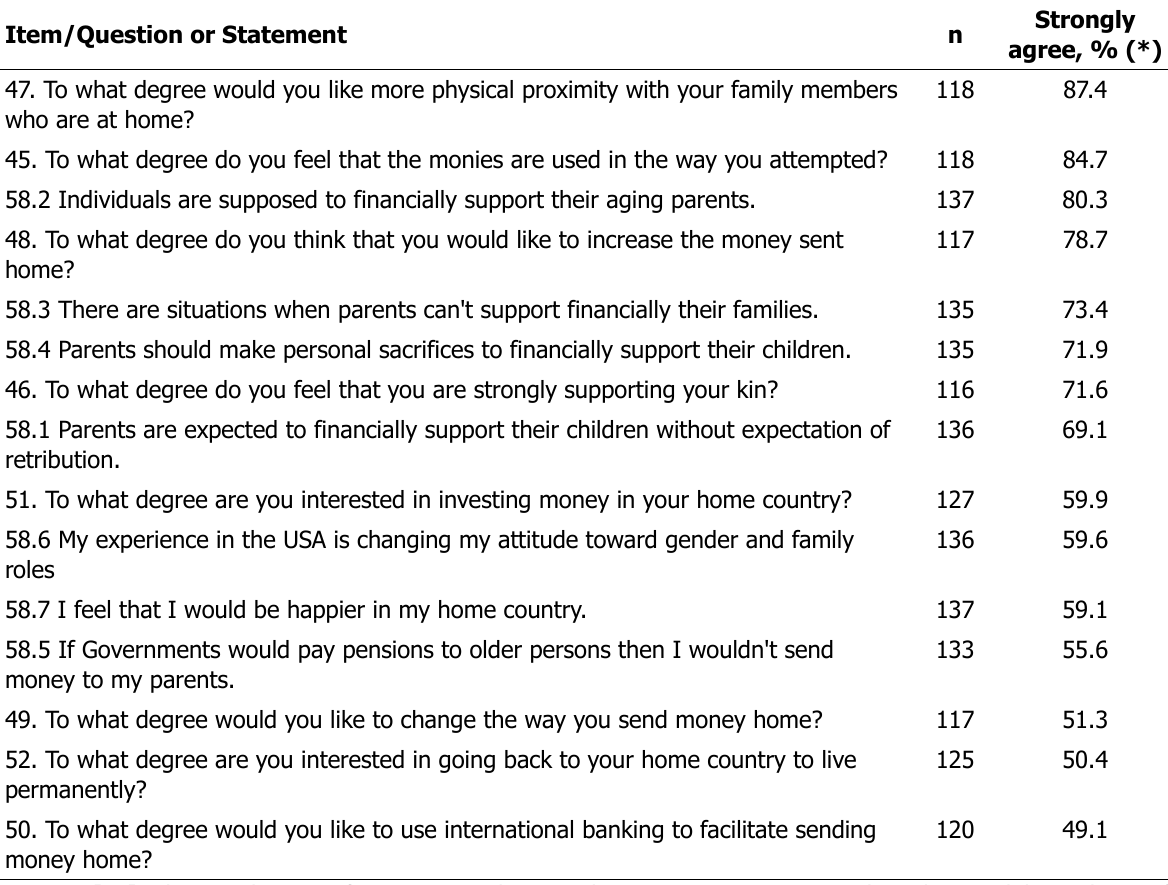
Table 2. 15 item scale on family responsibility and happiness.